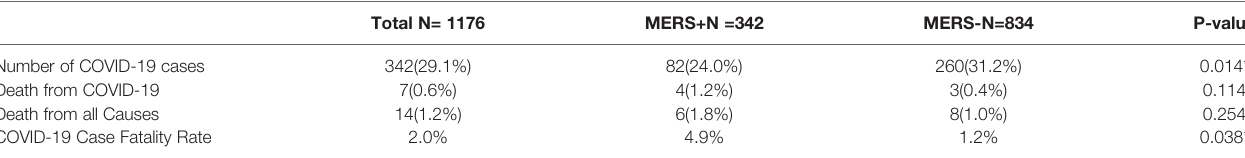
TABLE 2 | SARS-CoV-2 infection and mortality measures within the cohort subjects.